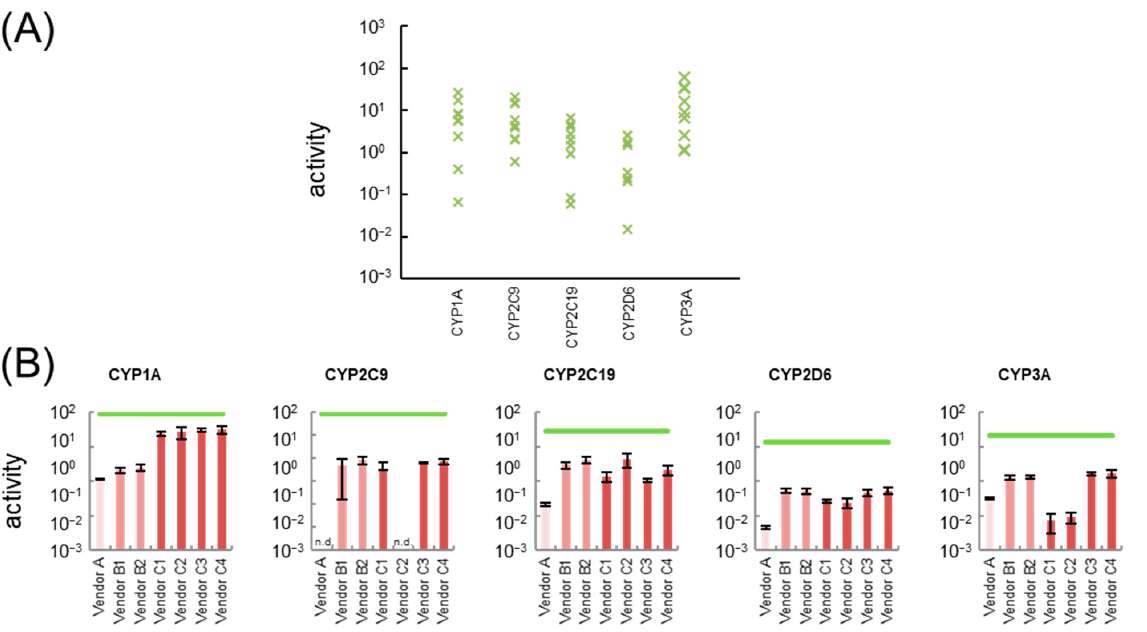
Figure 2. Comparison of the activity levels of cytochrome P450 (CYP) in hepatocyte-like cells derived from human induced pluripotent stem cells (hiPSC-Heps) with the minimum and maximum values of the expression in 8 lots of cryopreserved human hepatocytes (cryoheps). ( A ) Distribution of activity levels of CYPs in 8 lots of cryoheps. ( B ) The bars show the activity level of CYPs in hiPSC-Heps. The green line shows the average value of activity in 8 lots of cryoheps. n = 3. n.d, not detected. In hiPSC-Heps from vendor A, the expression levels of CYP1A1 and CYP3A5 were